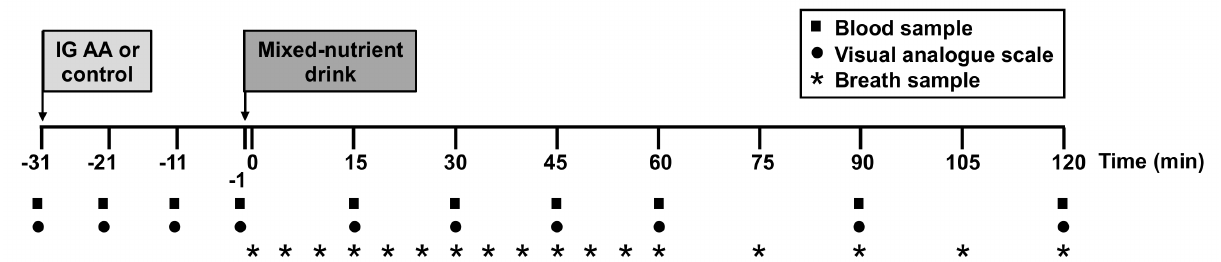
Figure 1. Schematic representation of the study design. At t = − 31 min, a baseline blood sample (for measurement of plasma glucose and glucoregulatory hormones) was collected and a visual analogue scale questionnaire (to assess GI symptoms) completed, then study treatments (either an amino acid (AA; leucine, isoleucine or valine) or control) were administered intragastrically within 1 min. After 30 min, at t = − 1 min, each participant consumed, within 1 min, 350 mL of a mixed-nutrient drink, containing 100 mg of 13 C-acetate for measurement of gastric emptying by 13 CO 2 breath test. Blood samples and visual analogue ratings were collected at the indicated time points throughout the study, and breath samples after the mixed-nutrient